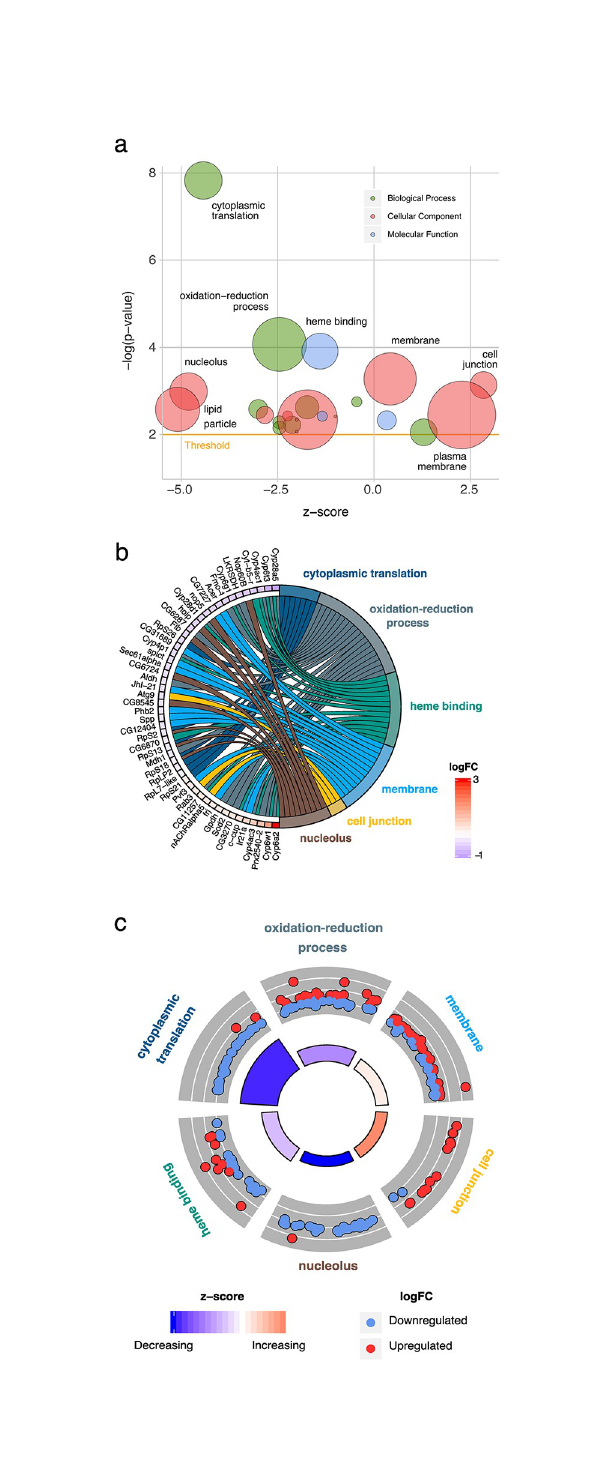
Fig 3. GO terms enriched by Clic knockdown. (a) Bubble plot depicting the top GO terms according to enrichment p-value and direction of regulation. Bubble radius is proportionate to GO term size in total number of genes and z- score represents overall direction of regulation of constituent differentially expressed genes. Threshold for significance set at enrichment p-value = 0.01 (orange line). (b) Chord plot displaying top 6 GO terms and their relationship to the top 50 differentially expressed genes. Differentially expressed genes (FDR � 0.05) were obtained from an FDR ranked